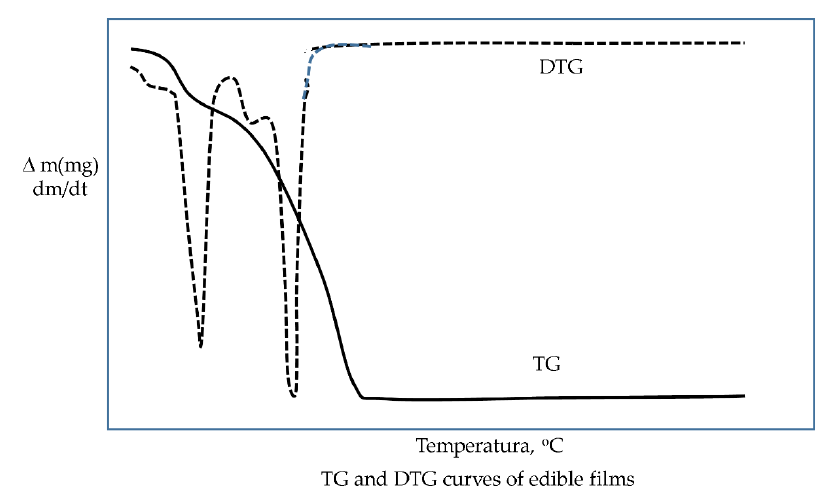
Figure 17. Typical thermal analysis of edible films .